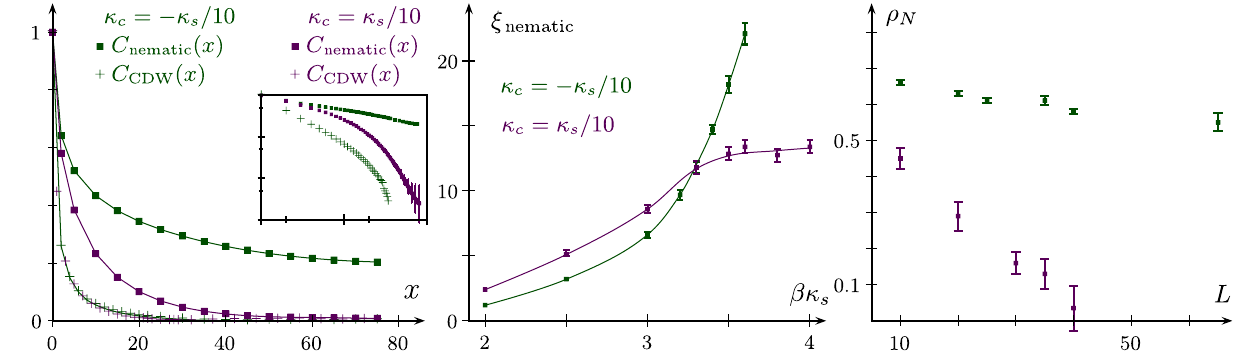
FIG. 5. Summary of numerical data. Left: Spatial decay of the correlation functions C and C . The inset shows a log-log plot nematic CDW of the same data. Combined error due to sampling and disorder averaging is shown where it exceeds the size of the shown data points. The qualitative feature that nematic correlations decay much slower than CDW correlations is generic for low temperatures and weak disorder. However, depending on parameters, C can either follow a power law or decay exponentially. Center: Temperature nematic dependence of the spin-nematic correlation length ξ shown for parameters corresponding to a SDW glass phase (green) or a fully nematic disorderd phase (purple) at low temperatures. For the first set of parameters, ξ grows rapidly as temperature is lowered, indicating a nematic phase transition into the SDW glass phase. For the second set of parameters, ξ N shows no sign of divergence and is expected to saturate at a finite value such that the low-temperature glassy phase is smoothly connected to the high-temperature phase. Solid lines are drawn as a guide to the eye. Right: The stiffness ρ N for spin-nematic fluctuations, as a function of system size, shown for both the SDW glass and the fully disordered phase. In the SDW glass ( κ c ¼ − 0 . 1 κ s ), ρ N depends only weakly on system size L and always takes a finite value, while for κ c ¼ 0 . 1 κ s it exhibits substantial sample dependence and rapidly decays with system